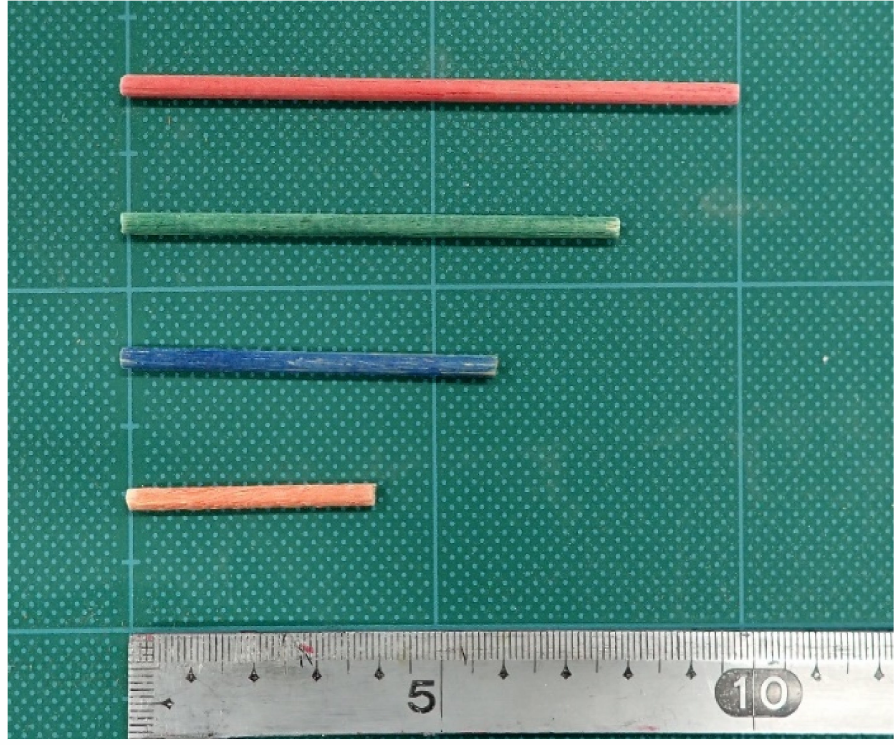
Figure 7. LW models with the following lengths: orange, 4 cm; blue, 6 cm; green, 8 cm; and red, 10